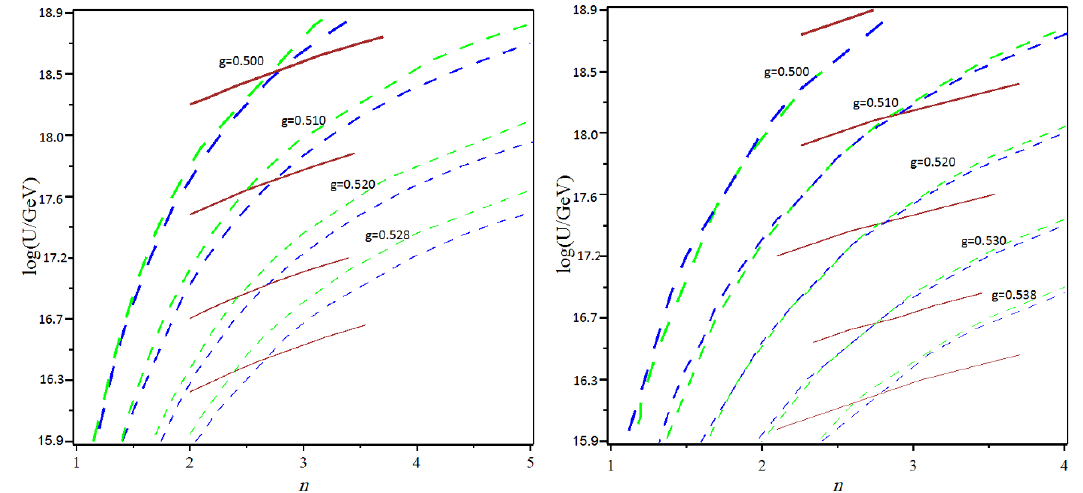
Figure 3 . Each line shows suitable choices of unification scale and n value at this scale, in order to revive experimental values of particle masses at low energies. Each set of three lines are for a specific g value and are illustrated with a particular thickness. The left hand side diagram incorporates two-loop corrections while the diagram on the right has only one-loop corrections. It can be inferred from diagrams that within a reasonable range of g , the lines associated with top quark, solid brown lines, and Higgs, dashed lines, always have a collision point. Therefore suitable n and U can be always found to assure the low energy values for the Higgs and top quark masses. This is true for both real and complex cases which are distinguished by blue and green lines respectively.